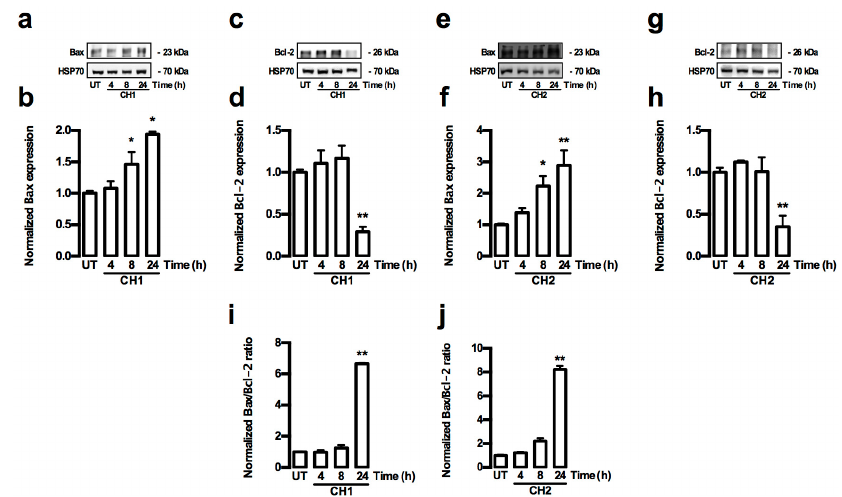
Figure 8. Chalcones-induced increase ratio Bax/Bcl-2 in HepG2 cells. ( a – h ) Cells were treated with CH1 and CH2 (50 μ M, each) and protein expression was analyzed; ( a , c , e , g ) Representative images from Western blot experiments performed for the detection of Bax and Bcl-2; ( b , d , f , h ) Densitometric analyses of the experiments shown in ( a , c , e , g ), respectively. ( i , j ) the data were presented in the bar graphs as Bax/Bcl-2 ratio. Protein levels were normalized against HSP70 and data were expressed relative to the UT (untreated) condition. Data are expressed as the mean ± standard error of the mean (SEM) from at least three independent experiments. Statistical differences were assessed by a one-way ANOVA (Kruskal–Wallis) followed by Dunn’s post hoc test. * p < 0.05; ** p < 0.01 vs. UT group.